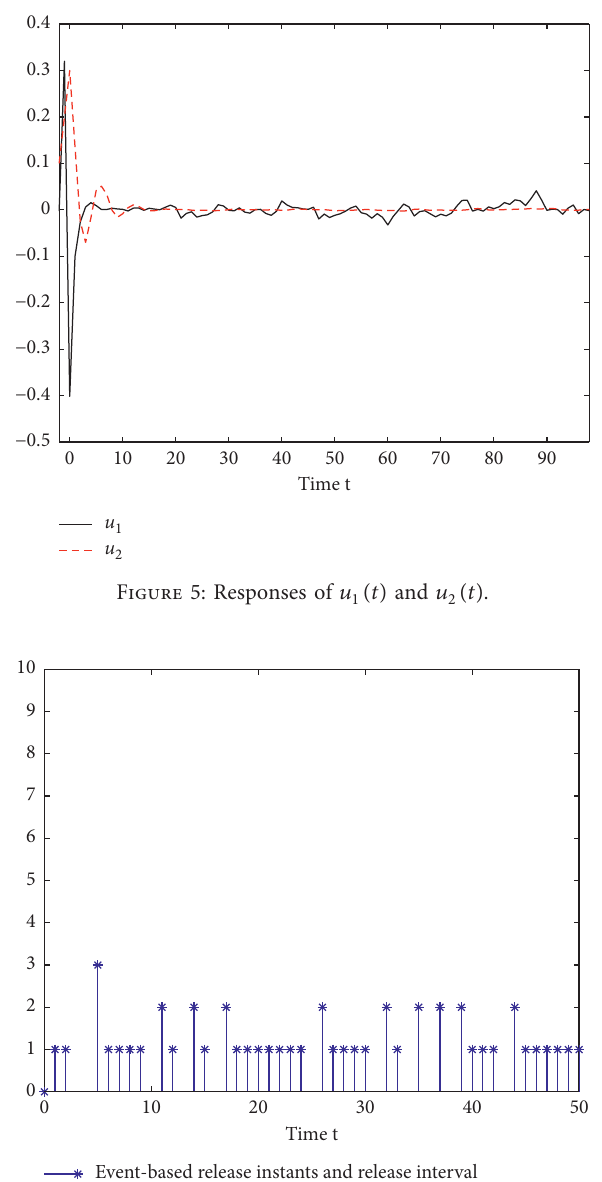
Figure 6: The dynamics of event-triggered